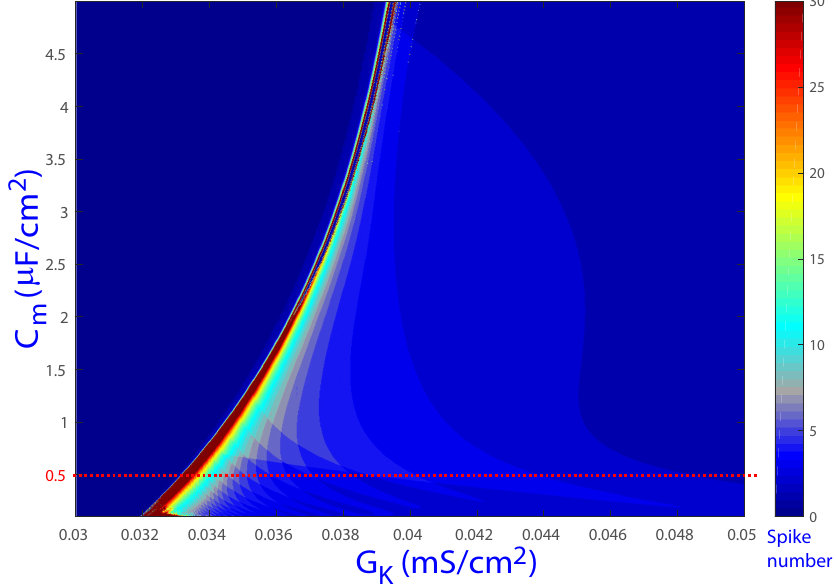
Figure 5. Regions of the spike-counting analysis for the biparametric plane ( G K , C m ). Different colors mark different numbers of spikes in the attracting orbit. A similar structure to that shown in Figure 2 can be observed. The red dashed line represents the value of C m = 0.5, studied below in